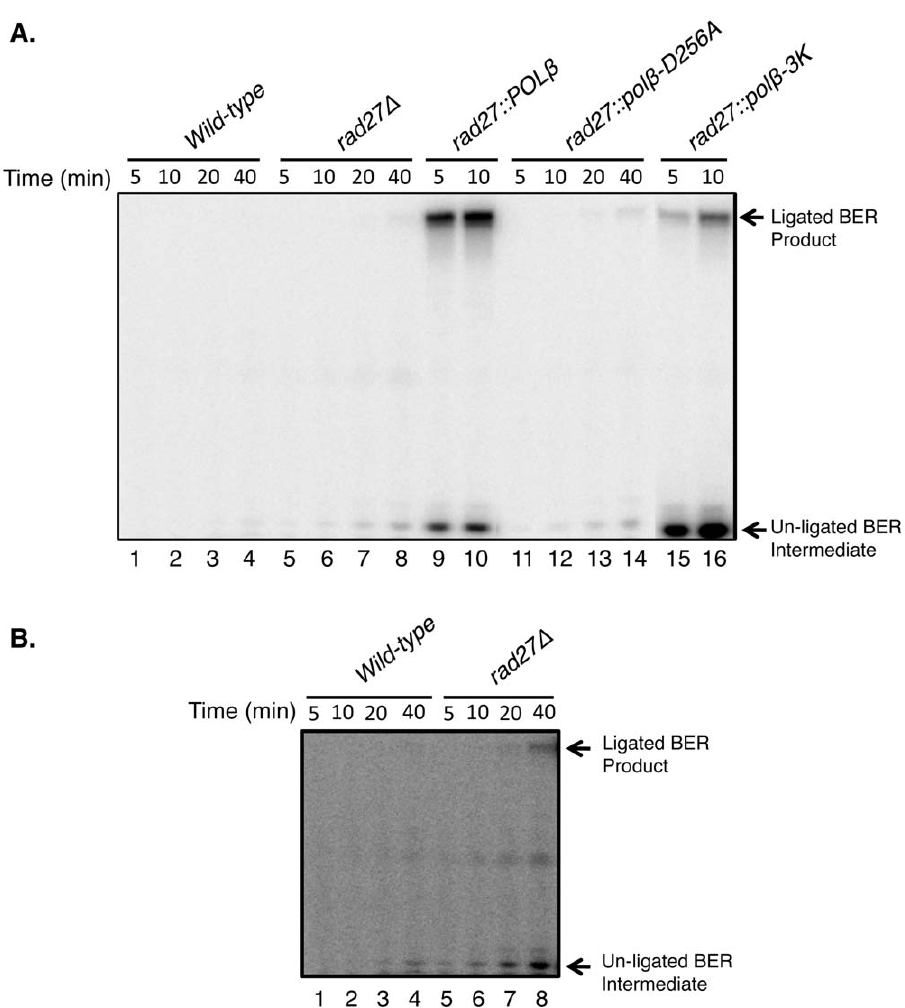
Figure 4. Invitro BER capacity of S.cerevisiae extracts. (A) Repair reactions were incubated either with extracts from wild-type (lanes 1–4), rad27 D (lanes 5–8), rad27::POL b (lanes 9–10), rad27::pol b -D256A (lanes 11–14), or rad27::pol b -3K (lanes15–16), respectively. Note that all the reaction mixtures were supplemented with human DNA ligase I (200 nM) as in Figure 4. Reaction mixtures were incubated at 35 u C and samples were withdrawn at the indicated periods. After incubation, the reaction products were processed as in Figure 3. The positions of ligated BER product and un-ligated BER intermediate are indicated. (B) Lanes 1 to 8 from the panel (A) were exposed for a longer time to observe BER products in the wild-type (lanes 1–4) and rad27 D (lanes 5–8)